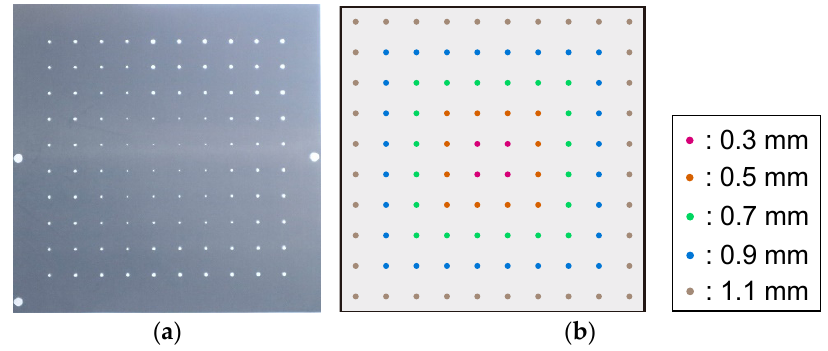
Figure 4. ( a ) Photograph of specimen (D); ( b ) profile sketch of specimen (D). Table 1. Parameters of the specimens. Note that the perforation ratios denote average values.